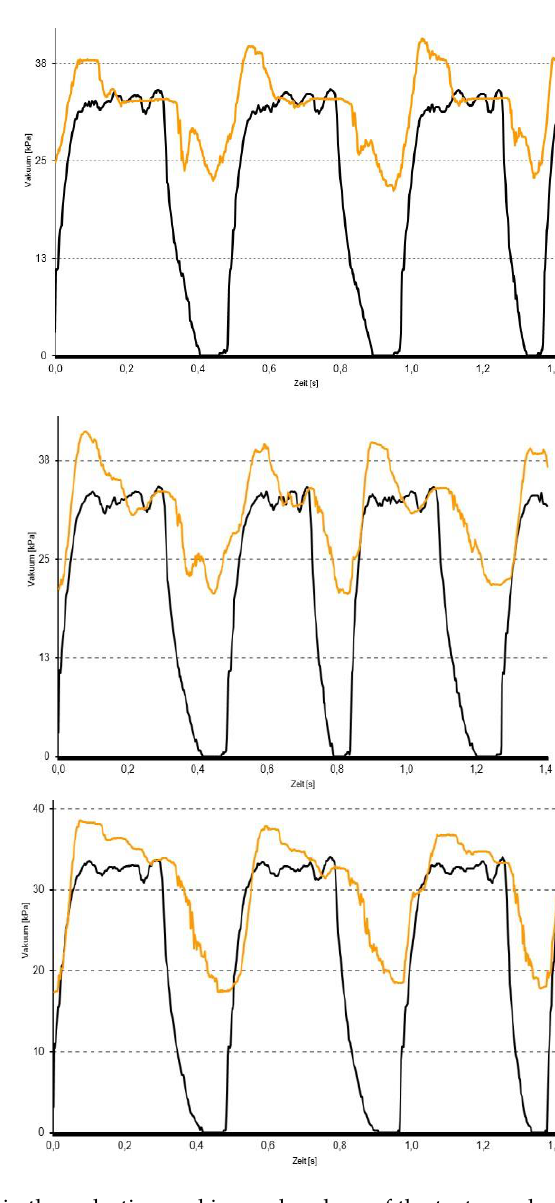
Figure 1. Cyclical vacuum fluctuations in the pulsation and inner chambers of the teat cup during milking the 1st WF in the sheep milking machine with the following settings: 34 vacuum level (kPa), 120 pulsation rate (cycles/min) and 60:40 pulsation